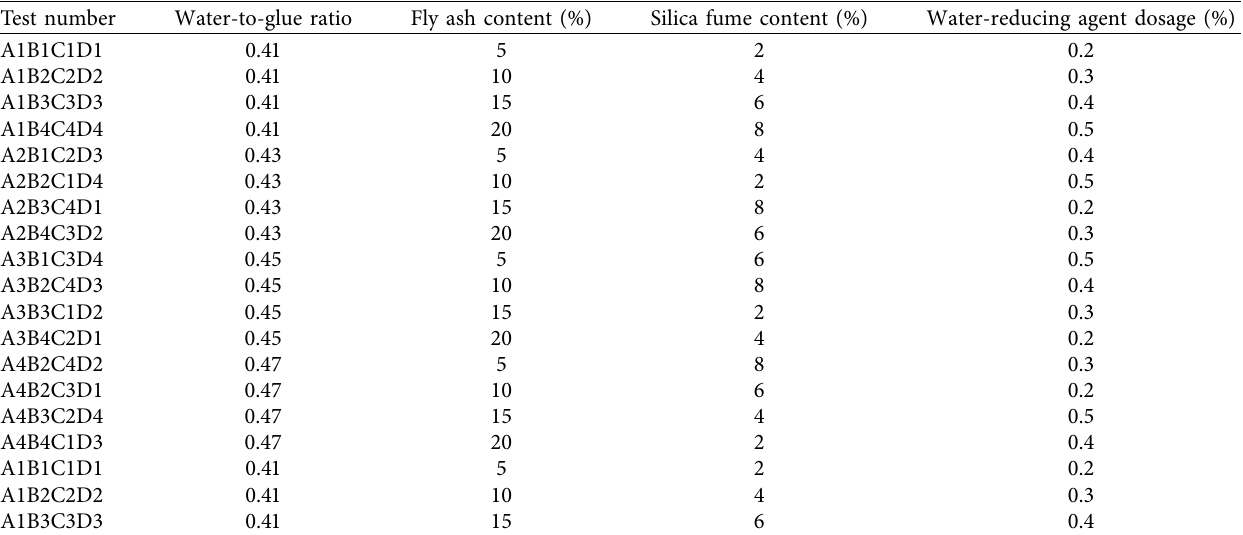
Table 1: Orthogonal test table for concrete mixture